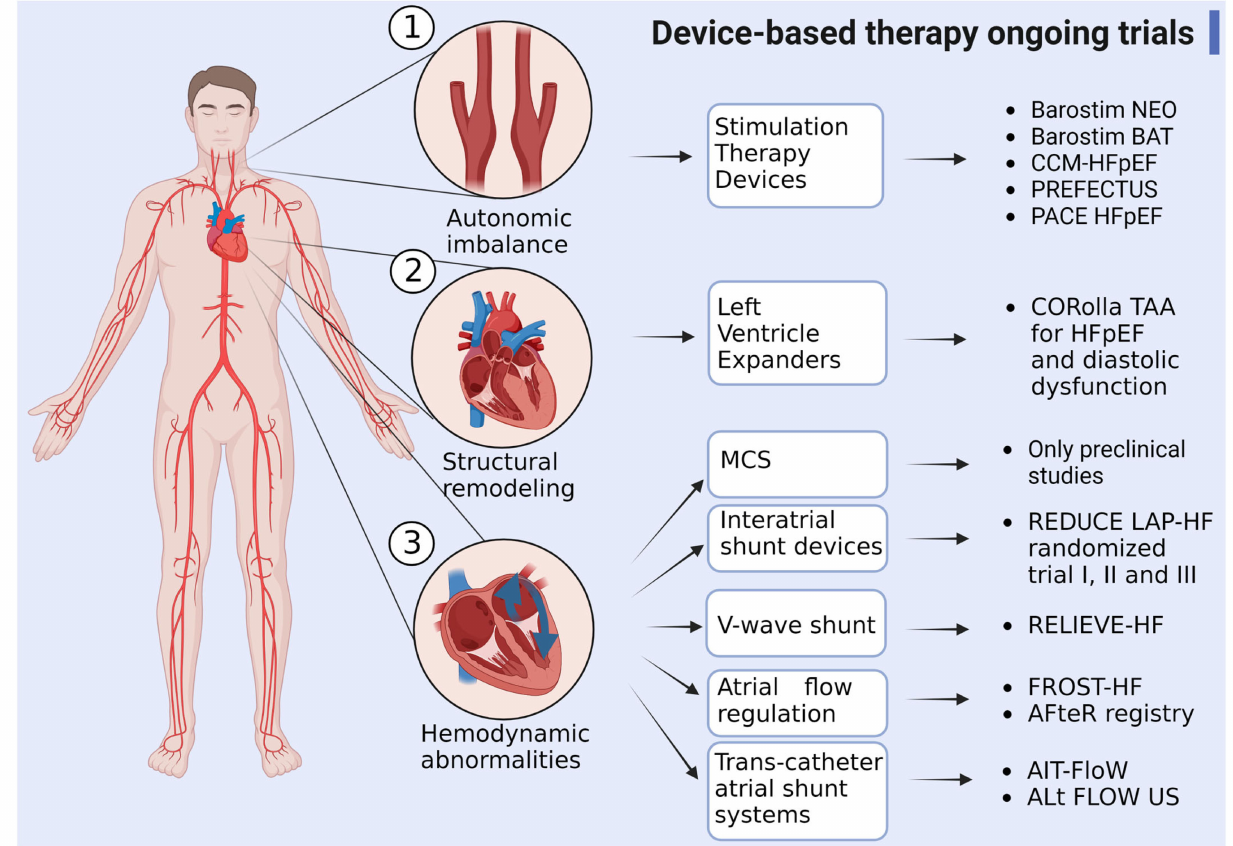
Figure 3. Device-based therapy in HFpEF. Summary of different devices for neurohumoral or mechan- ical targets in patients with HFpEF and ongoing trials both preclinical and clinical (CCM = cardiac contractility modulation; MCS = mechanical circulatory support) (created with